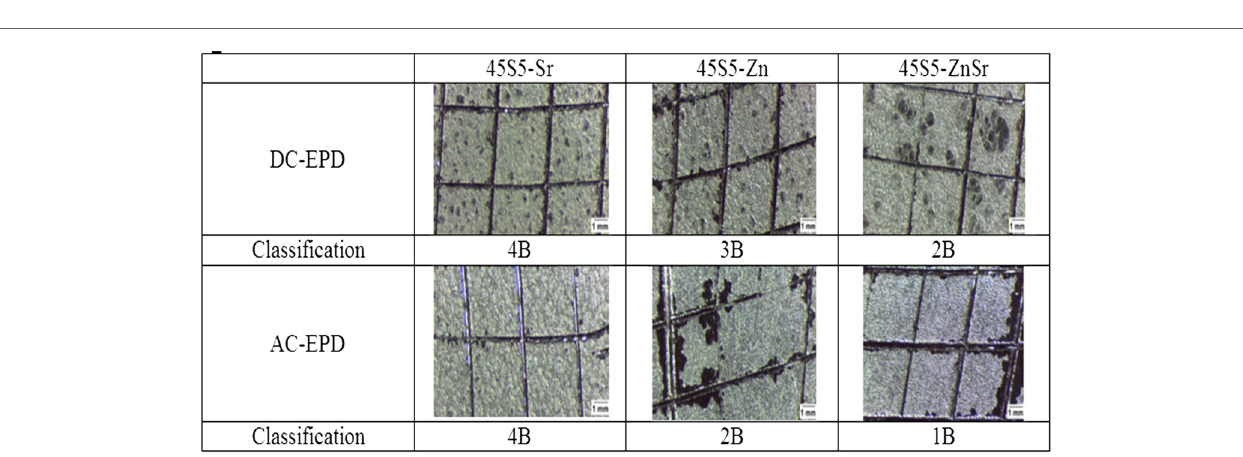
October 2015 | Volume 3 | Article 159 8